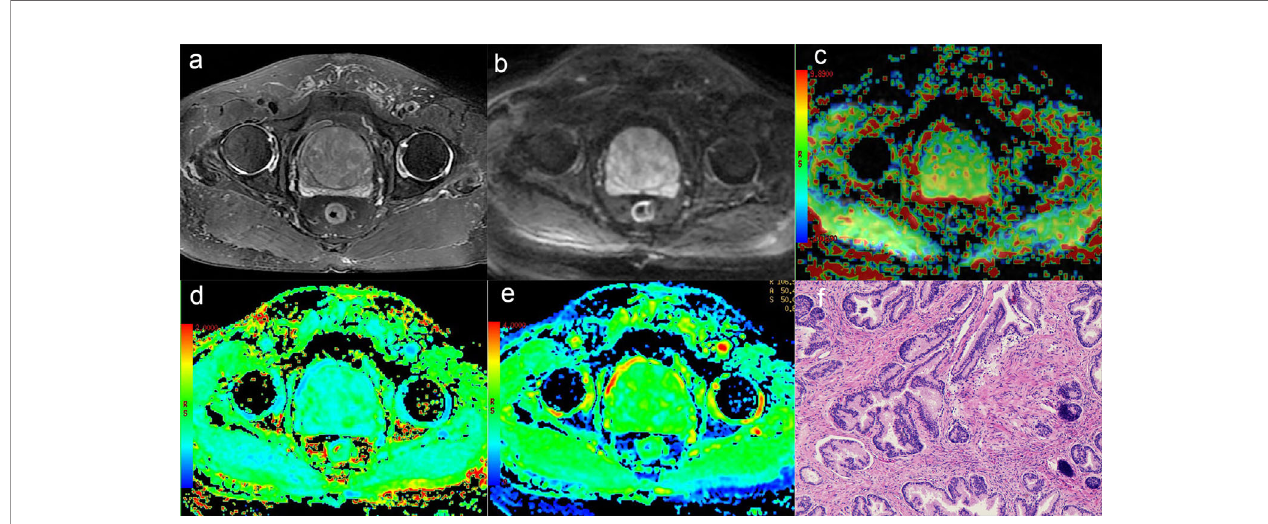
FIGURE 2 | A 75-year-old man with BPH. (A) T2-weighted image, (B) Diffusion-weighted image, (C) APT pseudo-colored map, (D) Mean kurtosis pseudo-colored map, (E) Mean diffusivity pseudo-colored map, (F) pathological image.